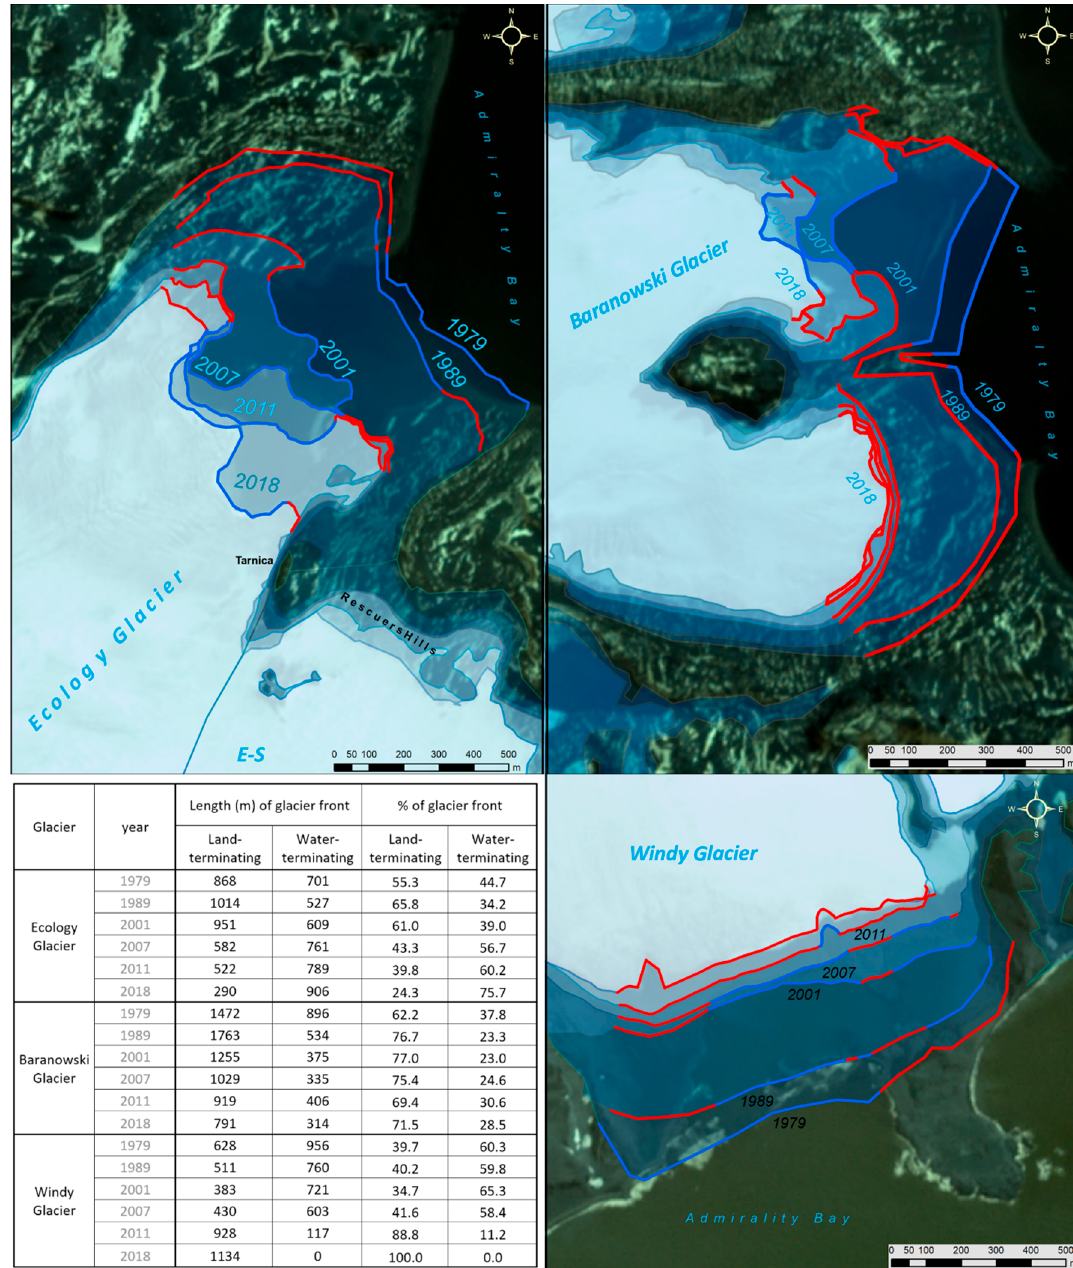
Figure A1. The length changes of land and water terminating fronts of Ecology, Baranowski and Windy glaciers. They are the largest glaciers supplied directly from the Warszawa Icefield (300–400 m a.s.l.). PlanetScope satellite image (10 March 2018) as a ortophotomap in the background.